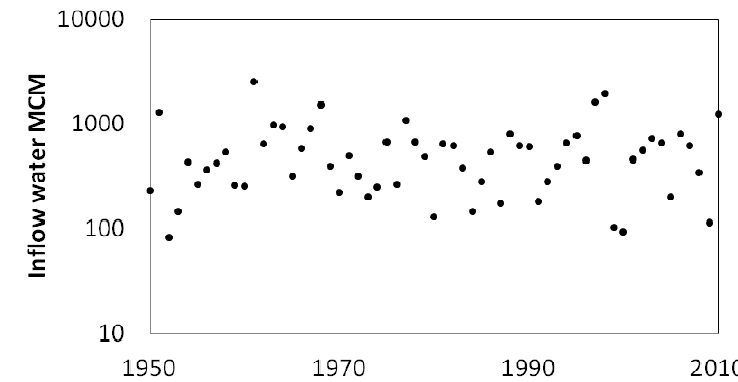
Figure 9. Total annual inflow (MCM) of water into the Lorian Swamp